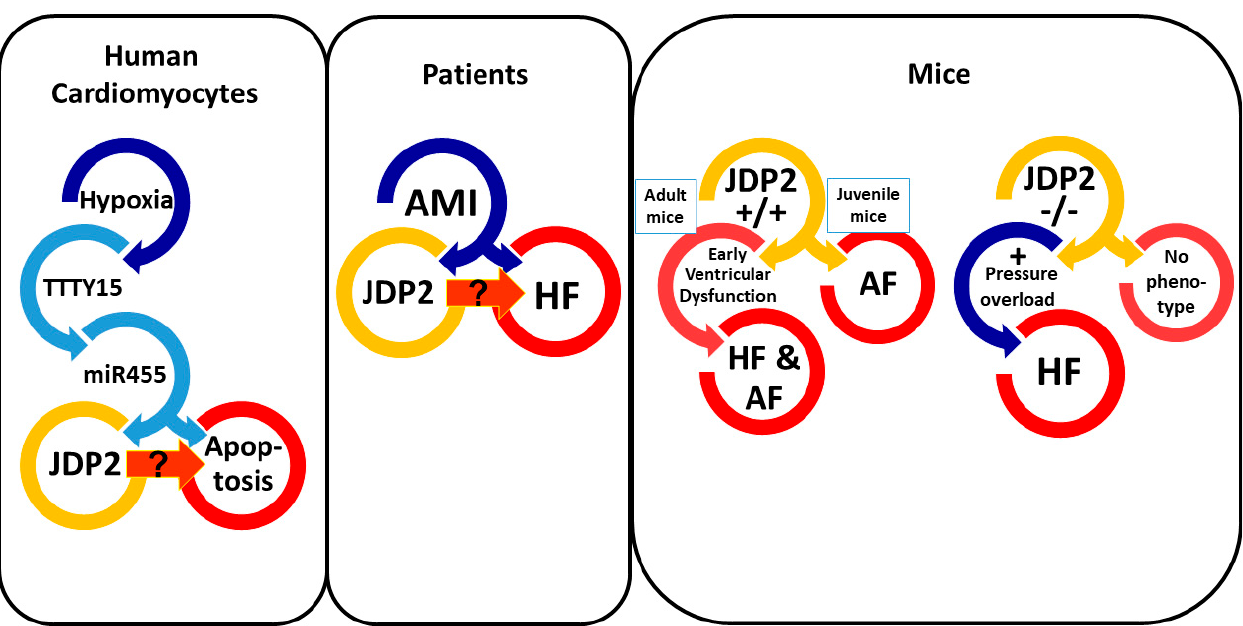
Figure 1. Overview about cardiac JDP2 effects. Summarized are results of studies about JDP2 effects in the heart and isolated cardiomyocytes. Table 1. Summary of available studies mentioned in this review that describe effects of JDP2 related to heart disease. Only main effects of JDP2 on ventricles or atria are listed. Arrows indicate up- or downregulation of JDP2 in the respective study. MI—myocardial infarction, HF—heart failure, PBMCs—peripheral blood mononuclear cells, CMs—cardiomyocytes, AF—atrial fibrillation, KO—knockout.